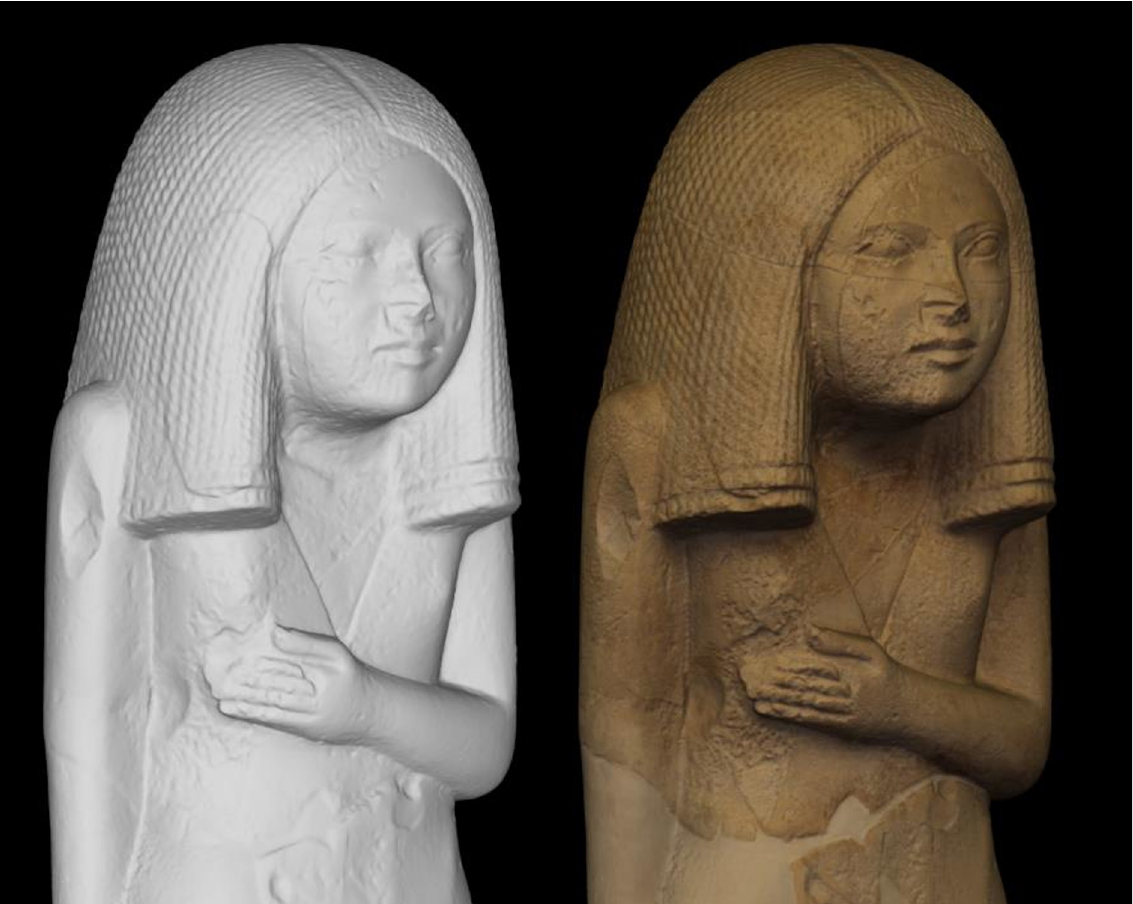
Fig. 3.6. Example of a photogrammetry model of the ‘Dame de Bruxelles’ (RMAH collections): on the left without the texture (colour); on the right with the texture. The model was generated in Agisoft Photoscan